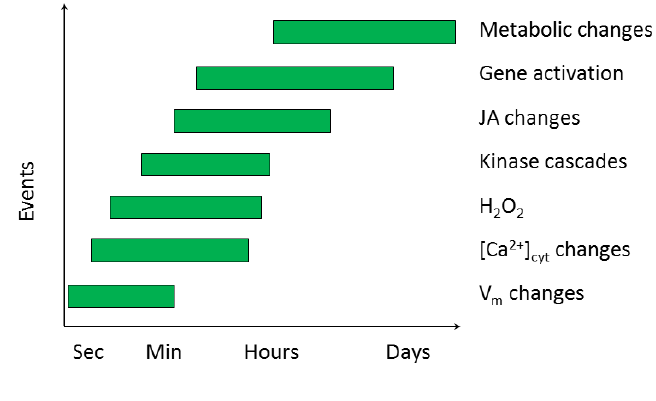
Figure 3. Events in plants after feeding by insect herbivores. Changes in the transmembrane ) appear immediately upon herbivory damage and are tightly followed by potential ( V m changes in the intracellular Ca 2+ concentration and generation of H phytohormone jasmonic acid (JA) are detectable within minutes. After roughly 1 h, gene activation followed by metabolic changes is seen (Adapted from